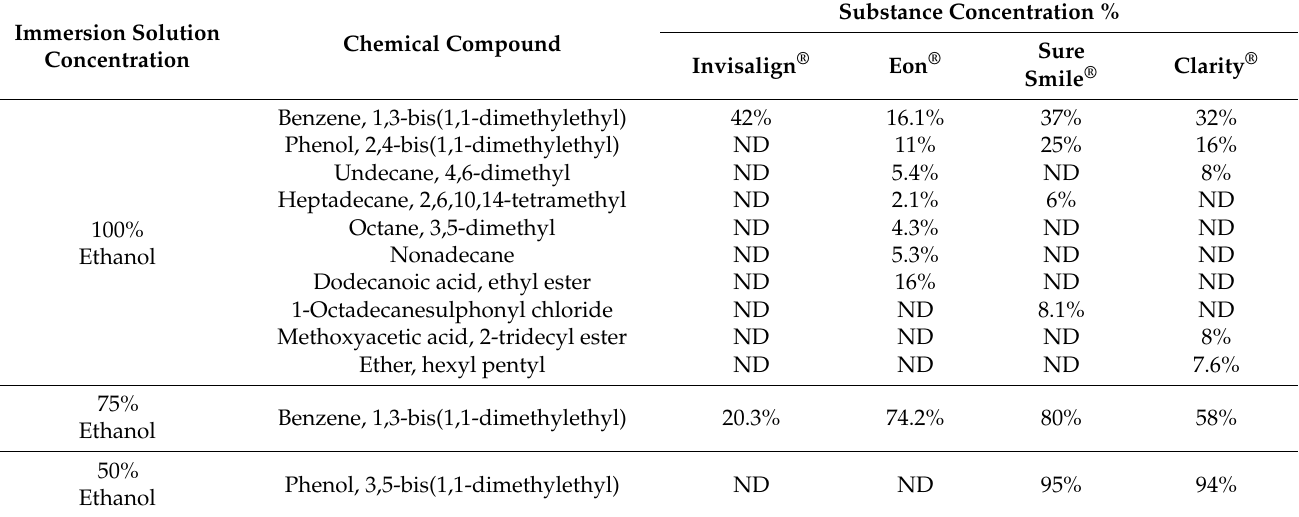
Table 1. Detected and confirmed chemical compounds and their concentrations in relation to clear aligners’ systems and immersion